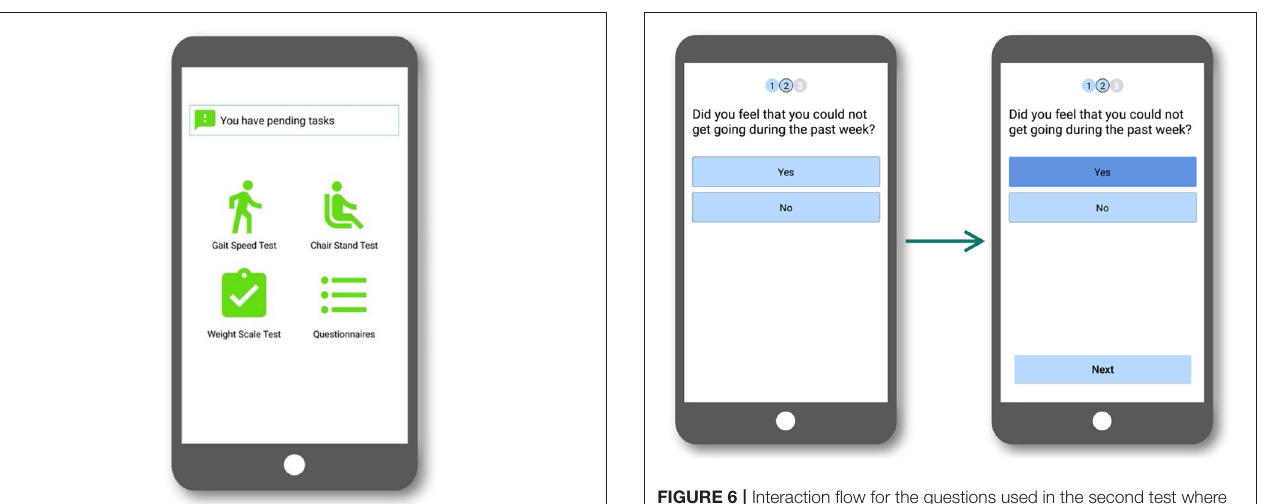
FIGURE 6 | Interaction flow for the questions used in the second test where pop-up messages were removed.